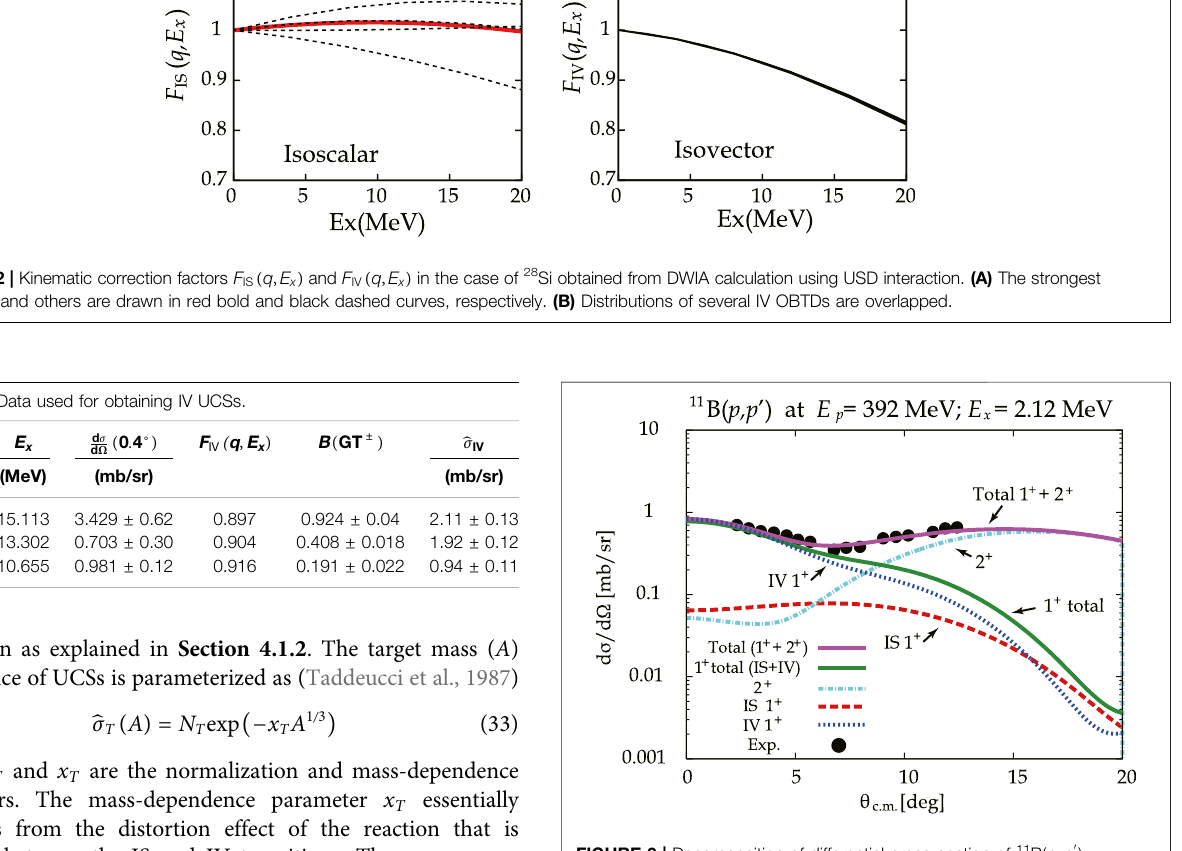
FIGURE 3 | Decomposition of differential cross-section of 11 B( p , p ′ ) reaction at E p (cid:1) 392 MeV compared to the state at E x (cid:1) 2 . 12 MeV. The experimental data were taken from Kawabata et al.